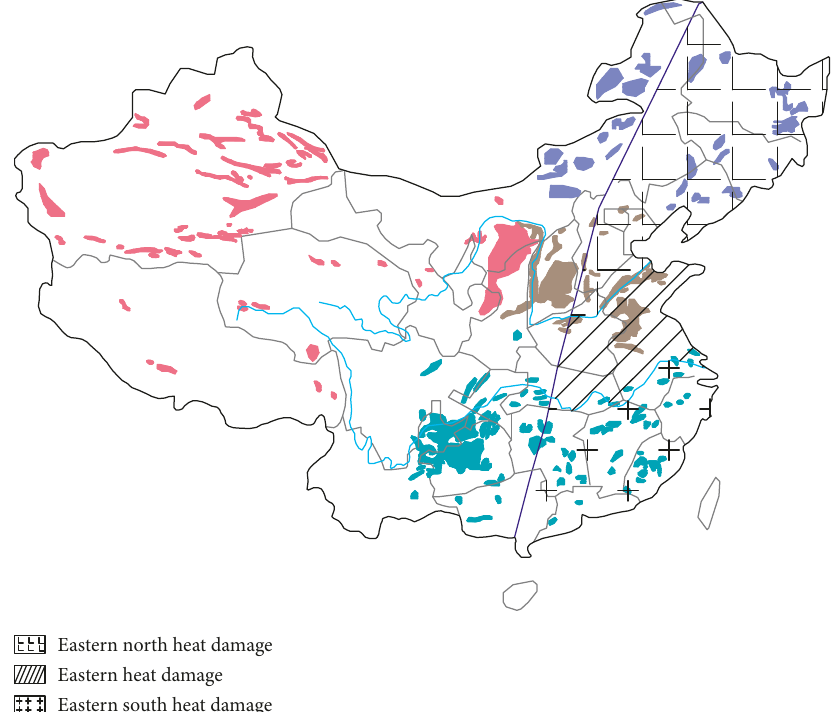
Figure 1: Distribution map of high-temperature mine in deep mining in